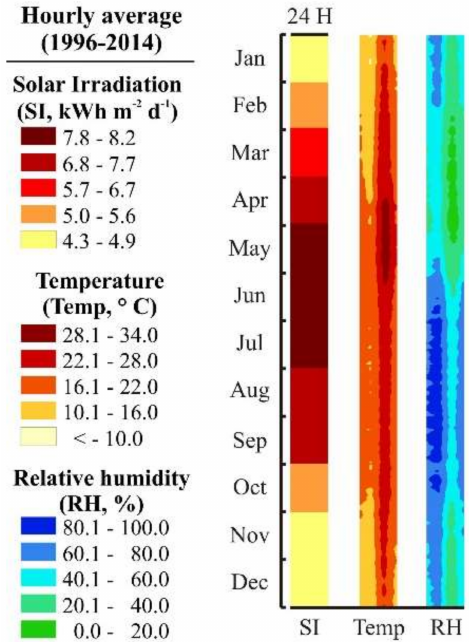
Figure 2. Annual average profile for solar irradiation, temperature and relative humidity in GMA.